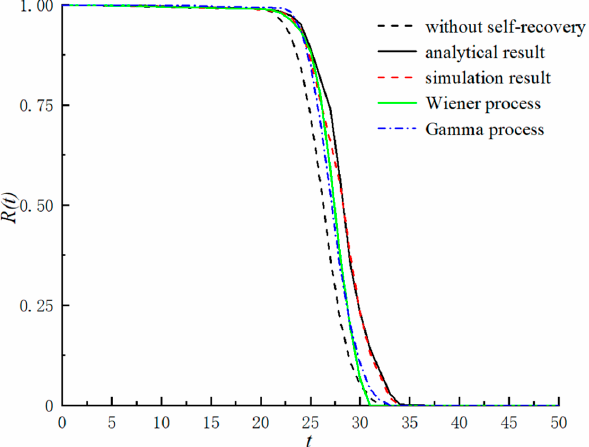
Figure 9. Reliability curves with varying models.